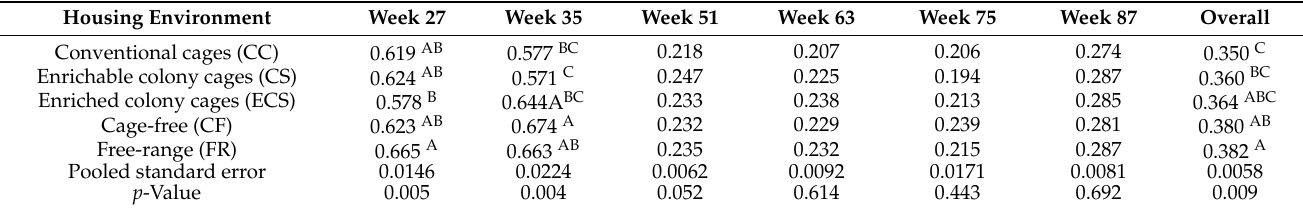
Table 9. The effect of housing environment on eggshell elasticity (mm) of brown egg layers by week and overall.